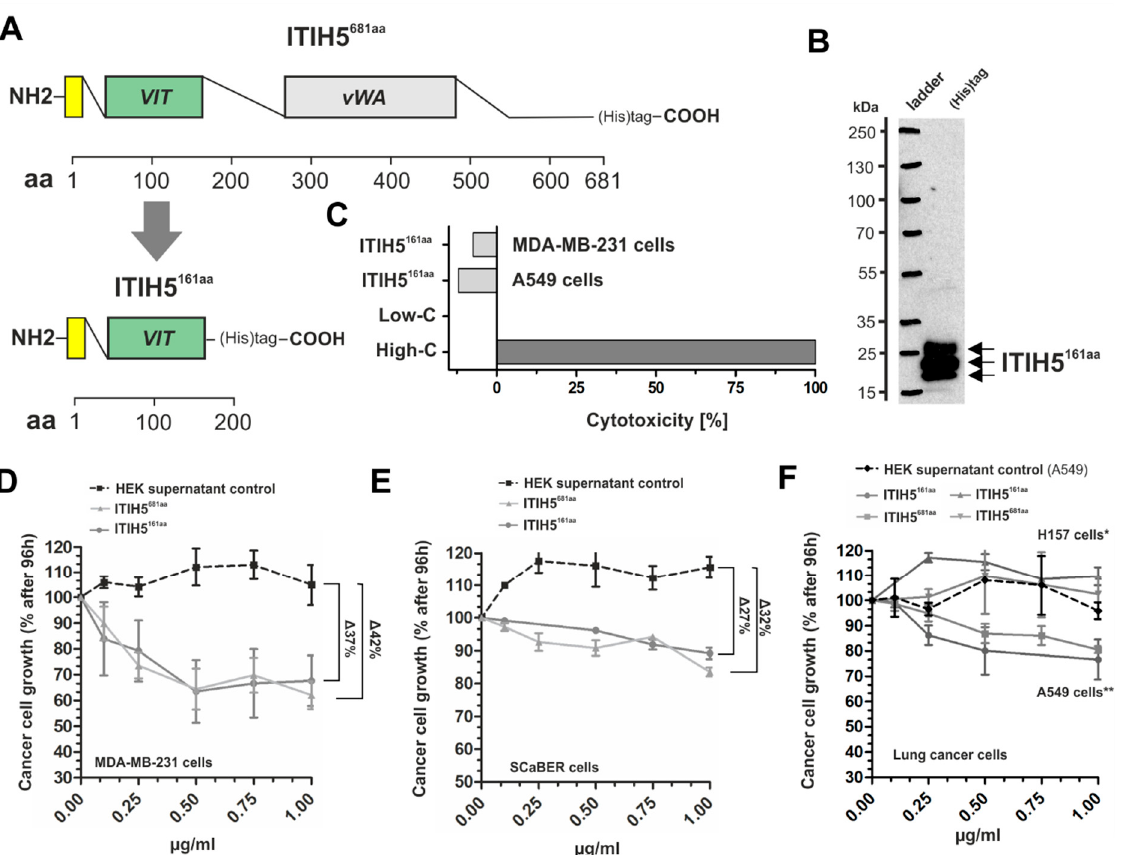
Figure 4. Tumor-suppressive impact of the recombinant VIT-domain containing polypeptide (ITIH5 161aa ) derived from the N -terminal ITIH5t protein applied to breast, bladder and lung cancer cells. ( A ) Schematic drawing of the N -terminal ITIH5 681aa polypeptide (681 aa) and the truncated ITIH5 161aa polypeptide (161 aa) covering the VIT domain. ( B ) Visualization of the recombinant